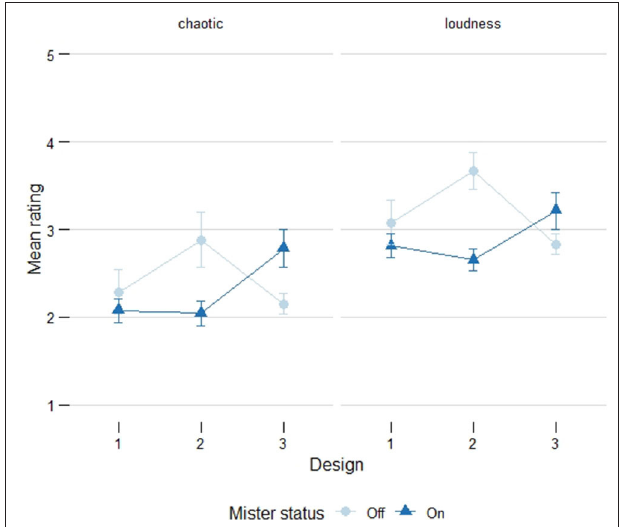
FIGURE 5 | Mean values for the chaotic and loudness ratings. The x-axis indicates the design and the lines compare the status of the mister (off/on). Errorbars indicate the standard error. The mean rating for chaotic and loudness scales was lower when the mister was on during Designs 1 and 2, but they were higher for Design 3, indicating that the mister did not have a consistent effect across designs.